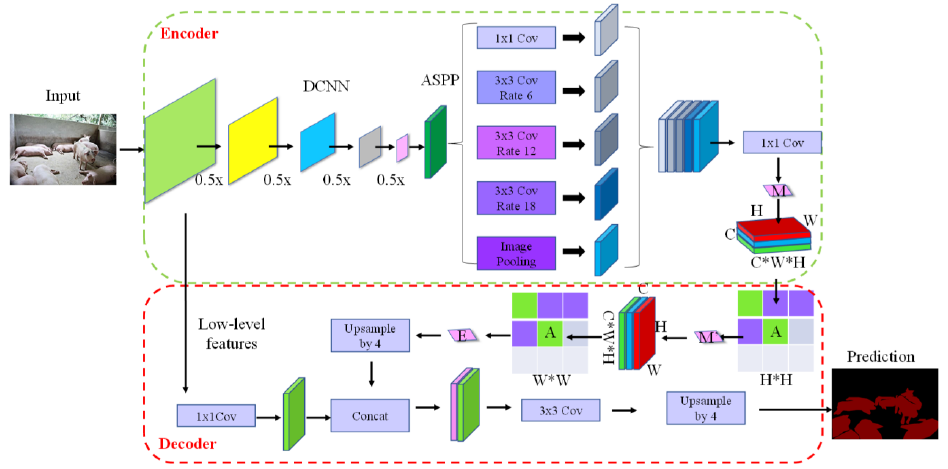
Figure 7. Light attention DeepLab V3+ network structure.